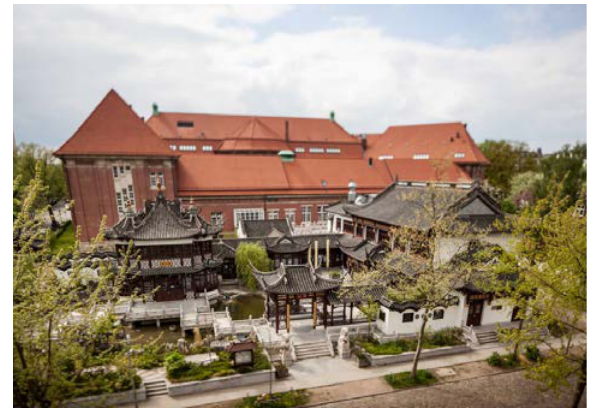
Figure 6. Yu Garden in Hamburg （ Image source: https://www.facebook.com/hamburg.yugarden?fref=ts